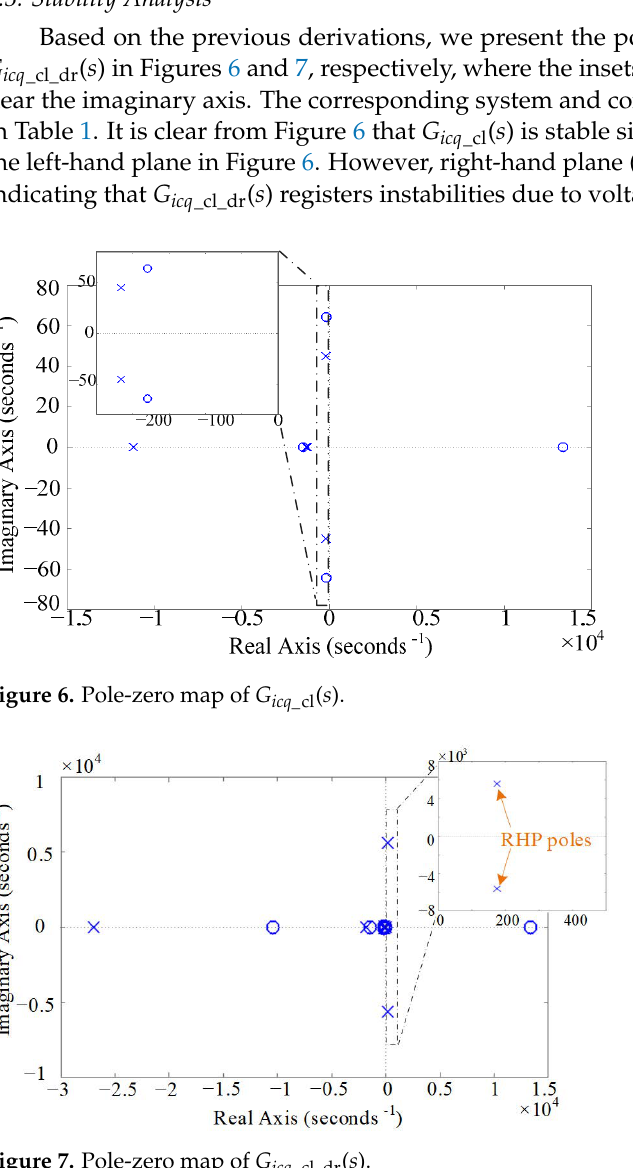
Figure 7. Pole-zero map of G icq _cl_dr ( s ).